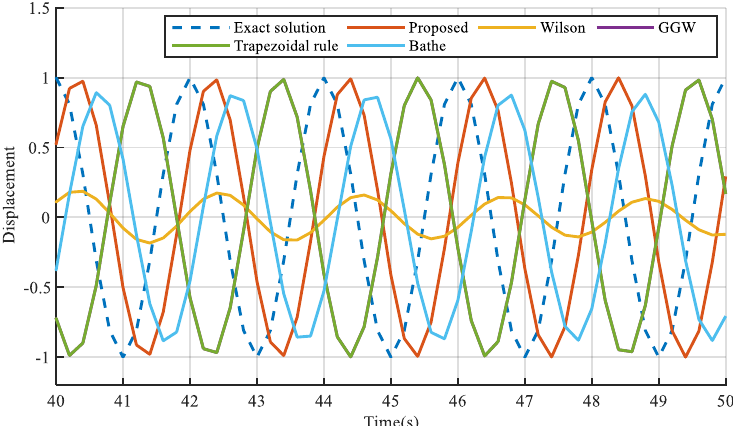
Figure 5. Displacement responses with the Wilson method, Bathe method, GGW method, trapezoidal rule, and the proposed method from 40 to 50 s.